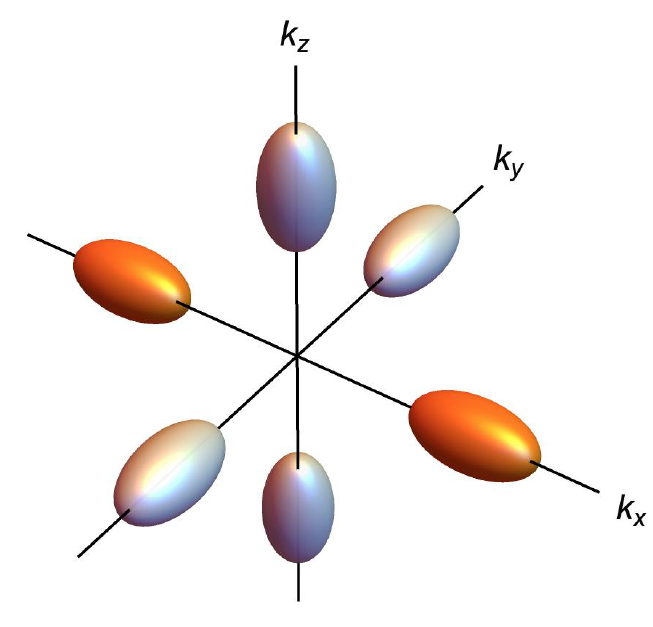
Figure A2. Constant energy surfaces for the ∆ valleys in the k-space used to represent the effective mass Hamiltonian for a silicon nanowire device. The principal valleys for transport are shown in orange. In our work the k x aligns with the channel of the wire.